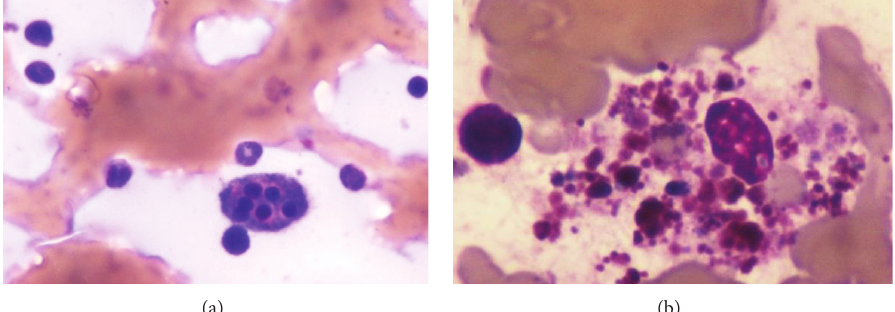
Figure 1: (a) Bone marrow aspiration of patient 1 and (b) bone marrow aspiration of patient 2, both showing macrophages phagocyting blood elements, hallmark of